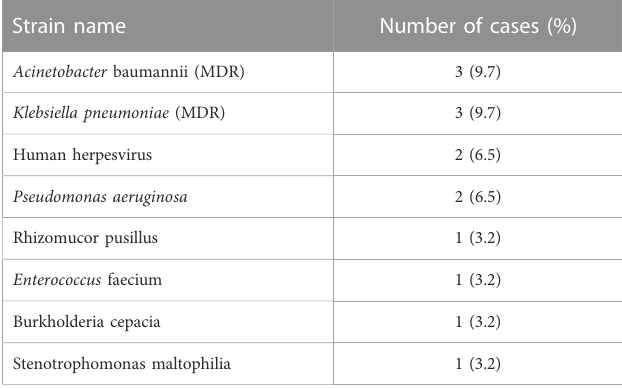
TABLE 4 Composition of other strains of 12 cases of mixed infection.